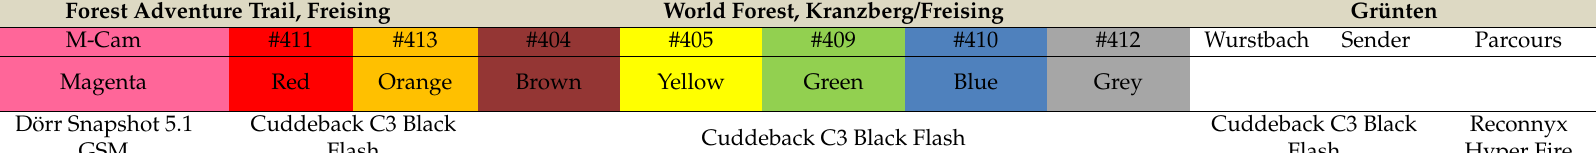
Table A1. Overview of camera types, sites, visitor monitoring questions; data for analysis